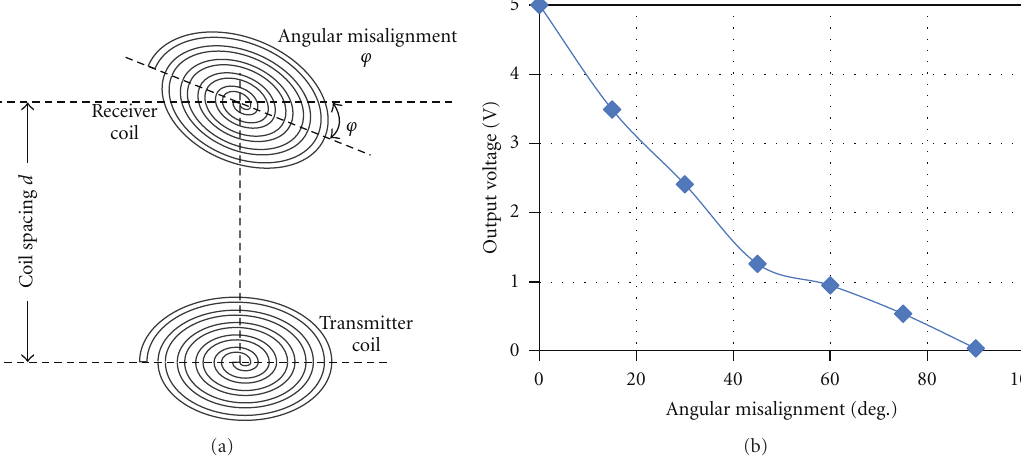
Figure 11: Illustration of angular misalignment ( ϕ ) between the transmitter and the receiver coils. (a) orientation of the coils. (b) the change of output for increase in angular misalignment. The coil spacing is kept fixed at 1cm, and lateral misalignment is